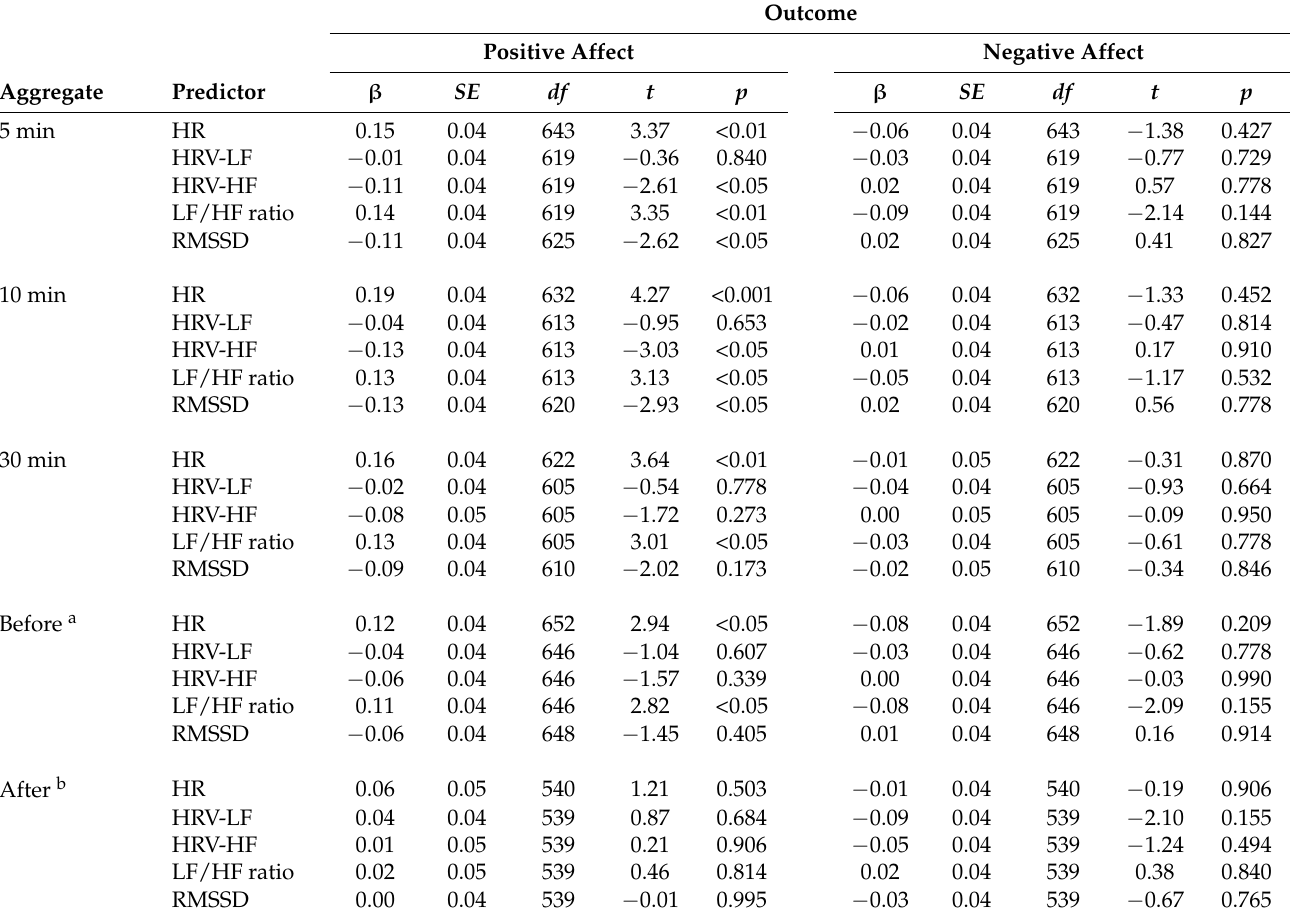
Table 5. Within-individual associations of HR and HRV parameters in different epoch lengths before or after filling out the ESM questionnaires with positive and negative affect sum scores stratified for being in an upright body position and being inactive.